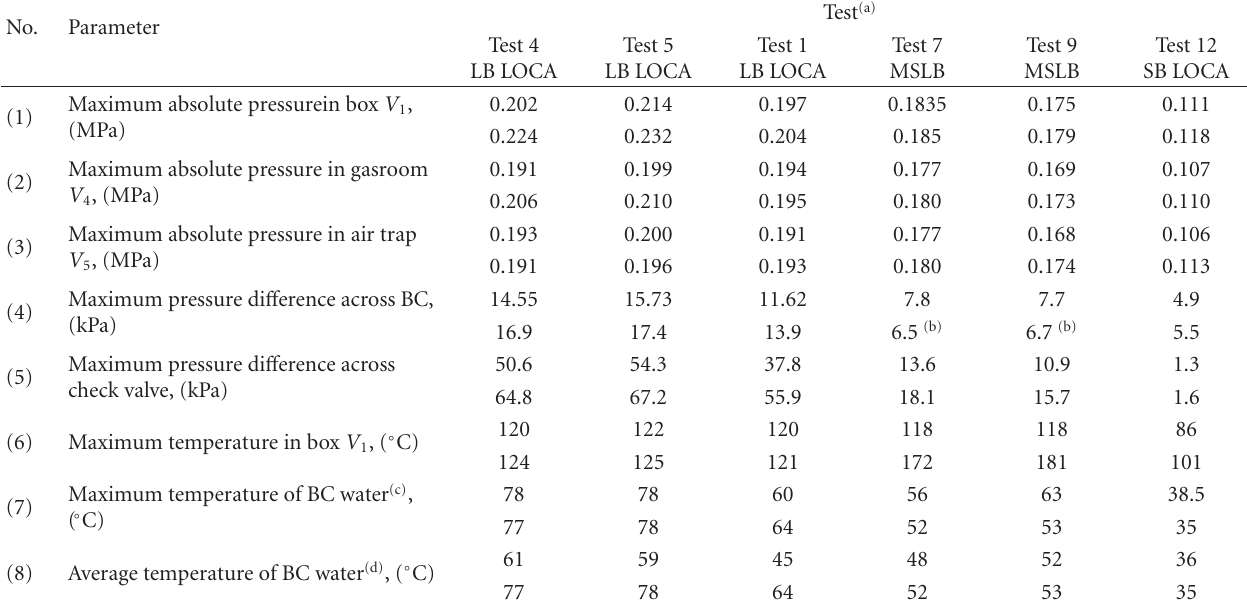
Table 8: Main experimental/calculated parameters characterizing loads on BC and